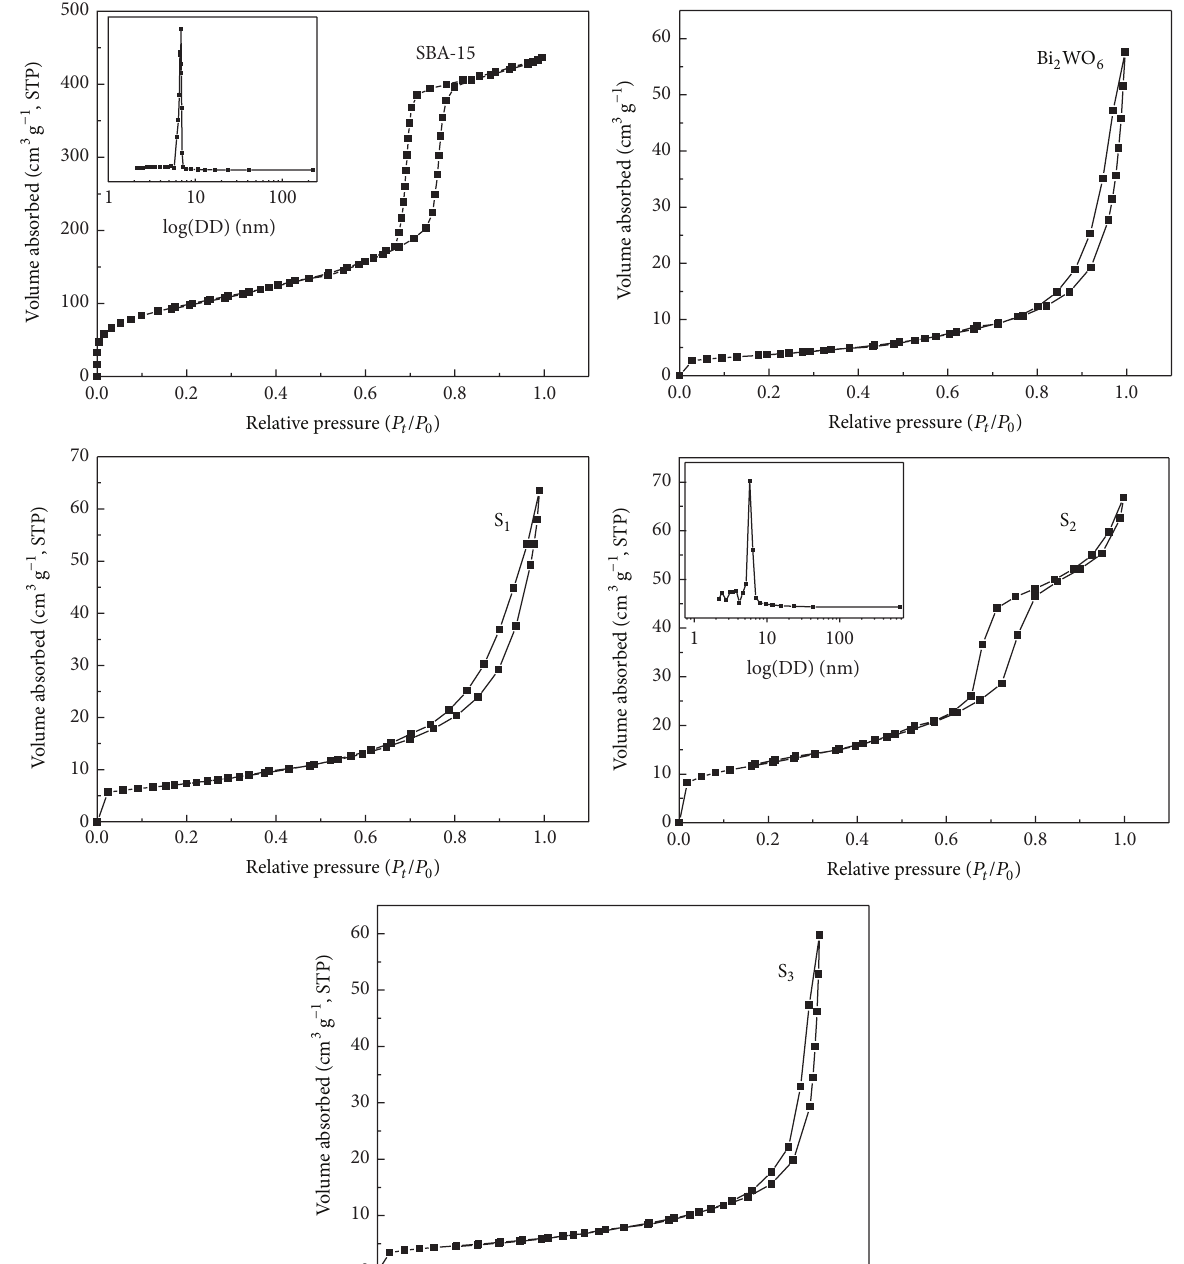
Figure 2: N 2 sorption isotherms and pore size distributions (inset) of the Bi 2 WO 6 , SBA-15, S 1 , S 2, and S 3 .